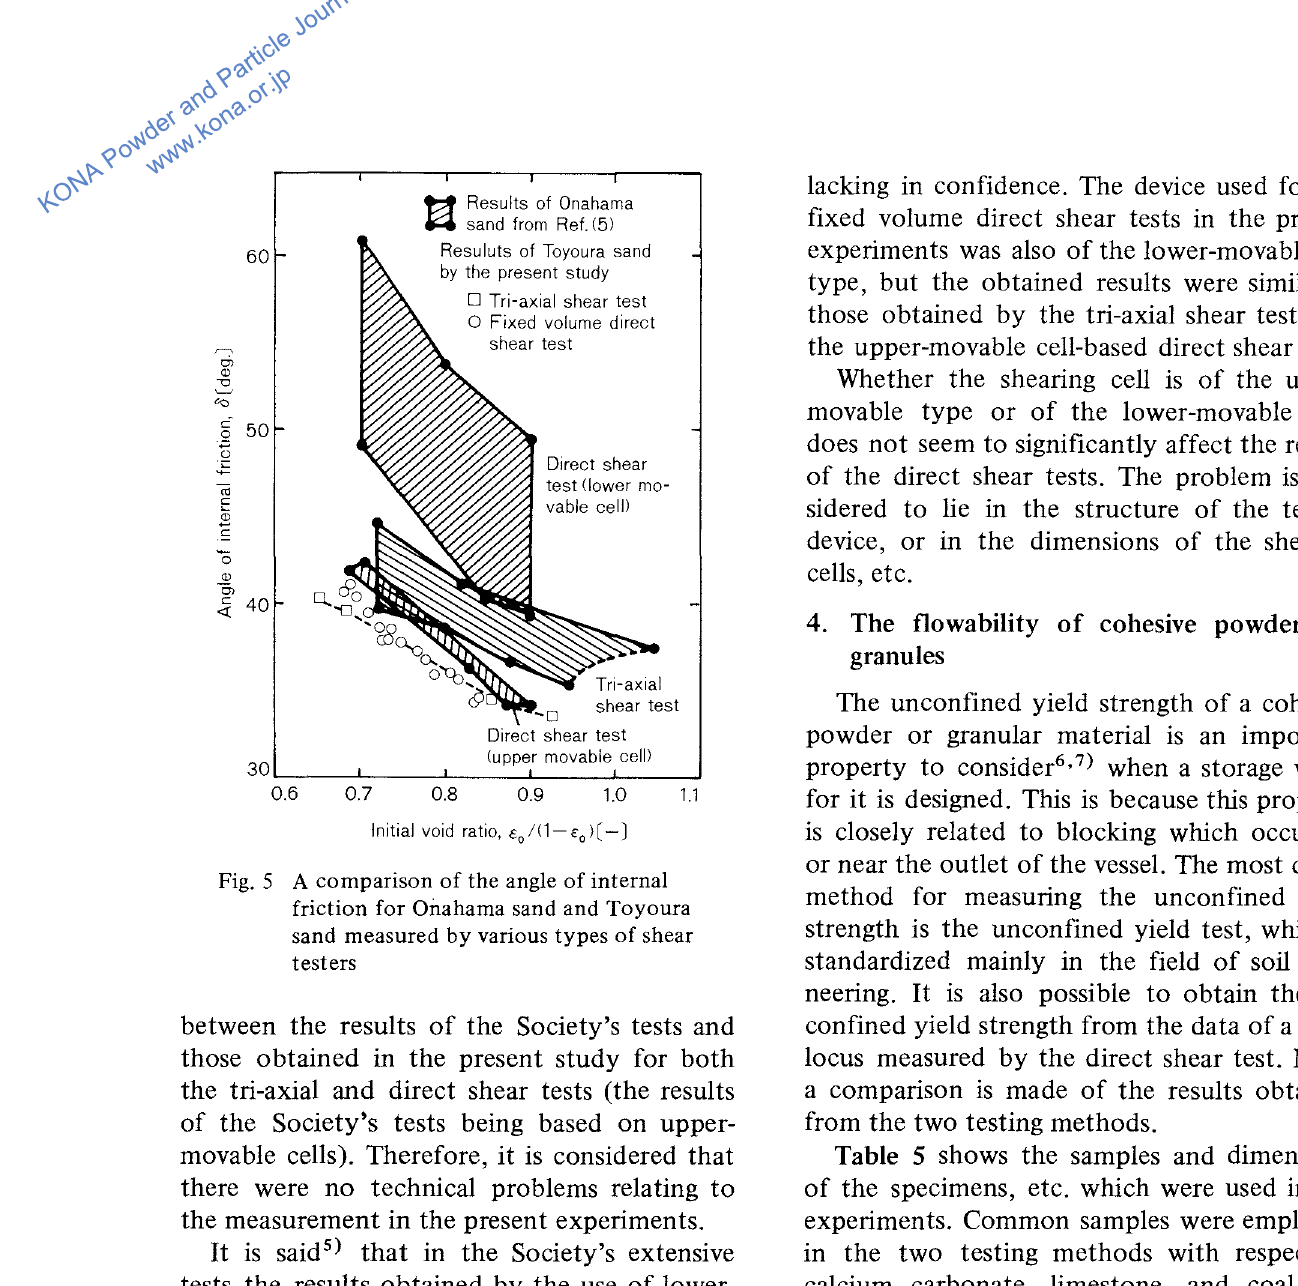
Table 5 The conditions of the experiment and materials used in the unconfined yield tests and the direct shear tests